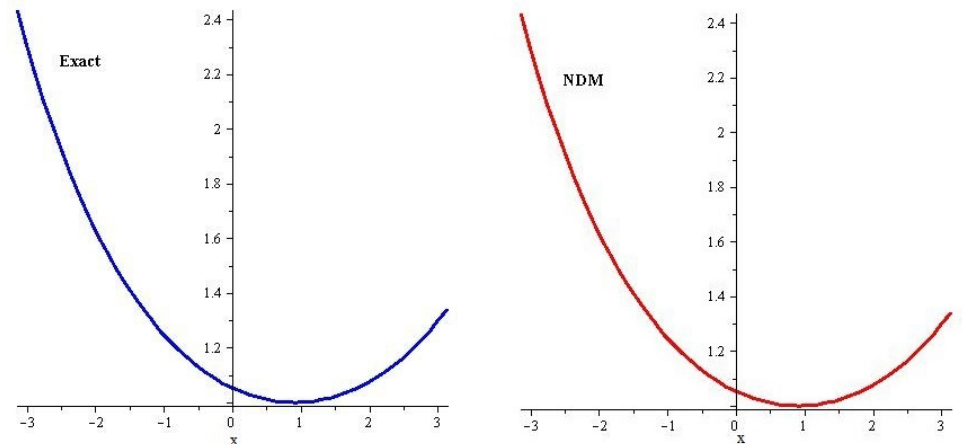
Figure 6. The graph of exact and approximate solution of Example 2.